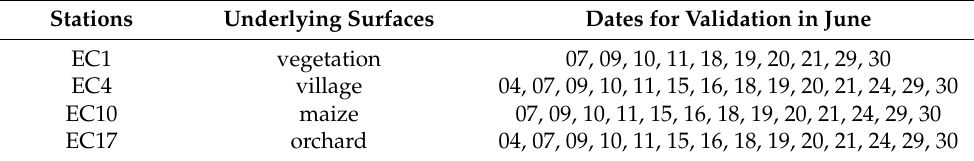
Figure 3. The core test area of HiWATER experiment and distributions of observation stations. Table 1. Descriptions of EC stations and dates used for